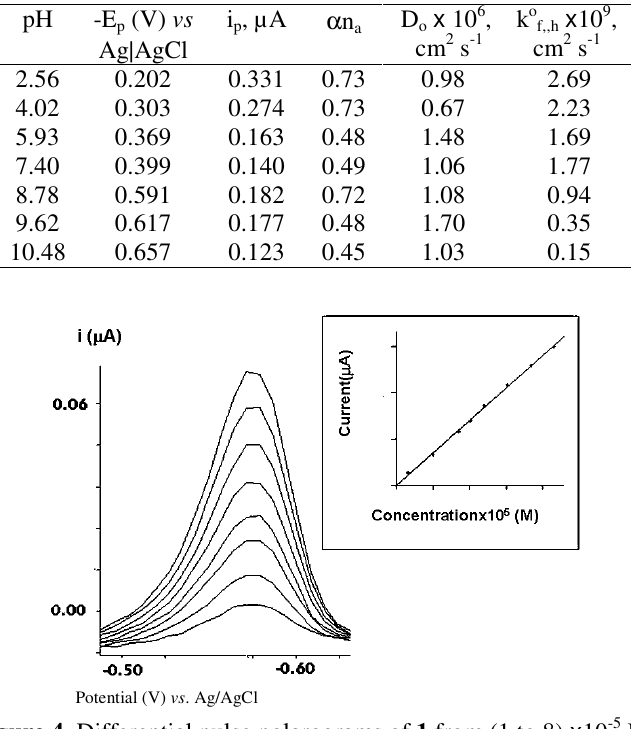
Figure 4. Differential pulse polarograms of 1 from (1 to 8) x 10 -5